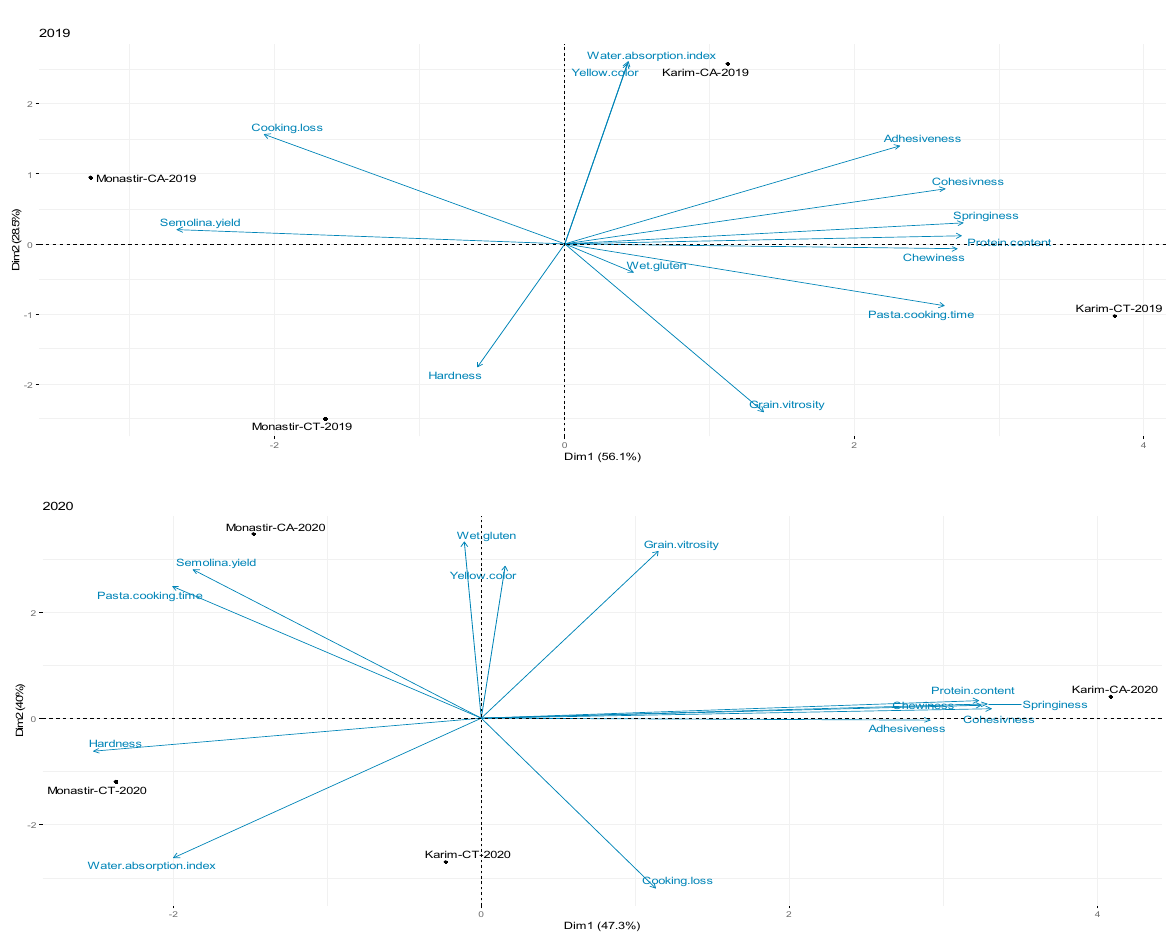
Figure 2. PCA for biplot of the quality parameters of “Monastir” and “Karim” varieties growing under CA and CT during 2019 and 2020.